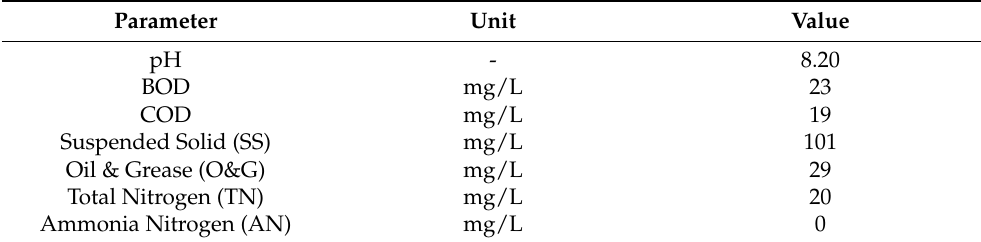
Table 1. Characteristics of AT-POME collected at final discharge.